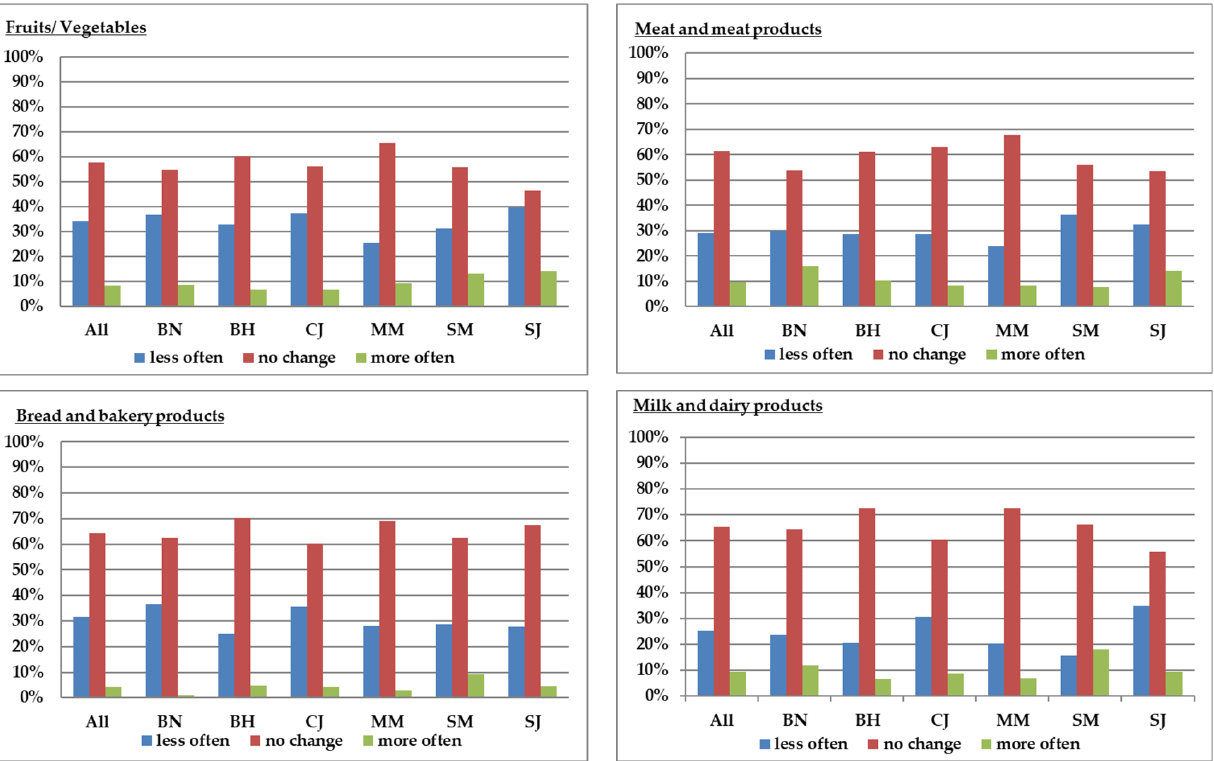
Figure 1. Frequency of buying food during the pandemic as compared to the pre-COVID-19 period (BN: Bistrita-Nasaud, BH: Bihor, CJ: Cluj, MM: Maramures, SM: Satu-Mare, SJ: Salaj).